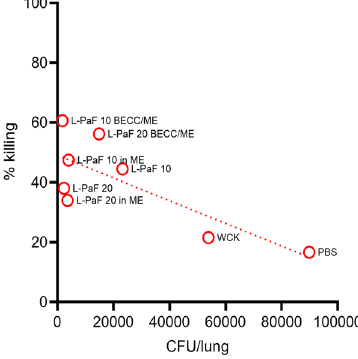
Fig. 6 Correlation between in vitro (OPK) and in vivo reduction in lung burden. Groups with high in vitro killing ability harbor fewer lung bacteria in vivo. Pearson ’ s r coef fi cient and simple linear regression (95% con fi dence level) were calculated. r = − 0.7759, 95% con fi dence interval = − 0.9572 to − 0.1572, R squared = 0.6020, p value (two-tailed) = PBS vaccinated mice (Fig. 7B) with the latter leading to increased pro-in fl ammatory responses. These mice had experienced similar